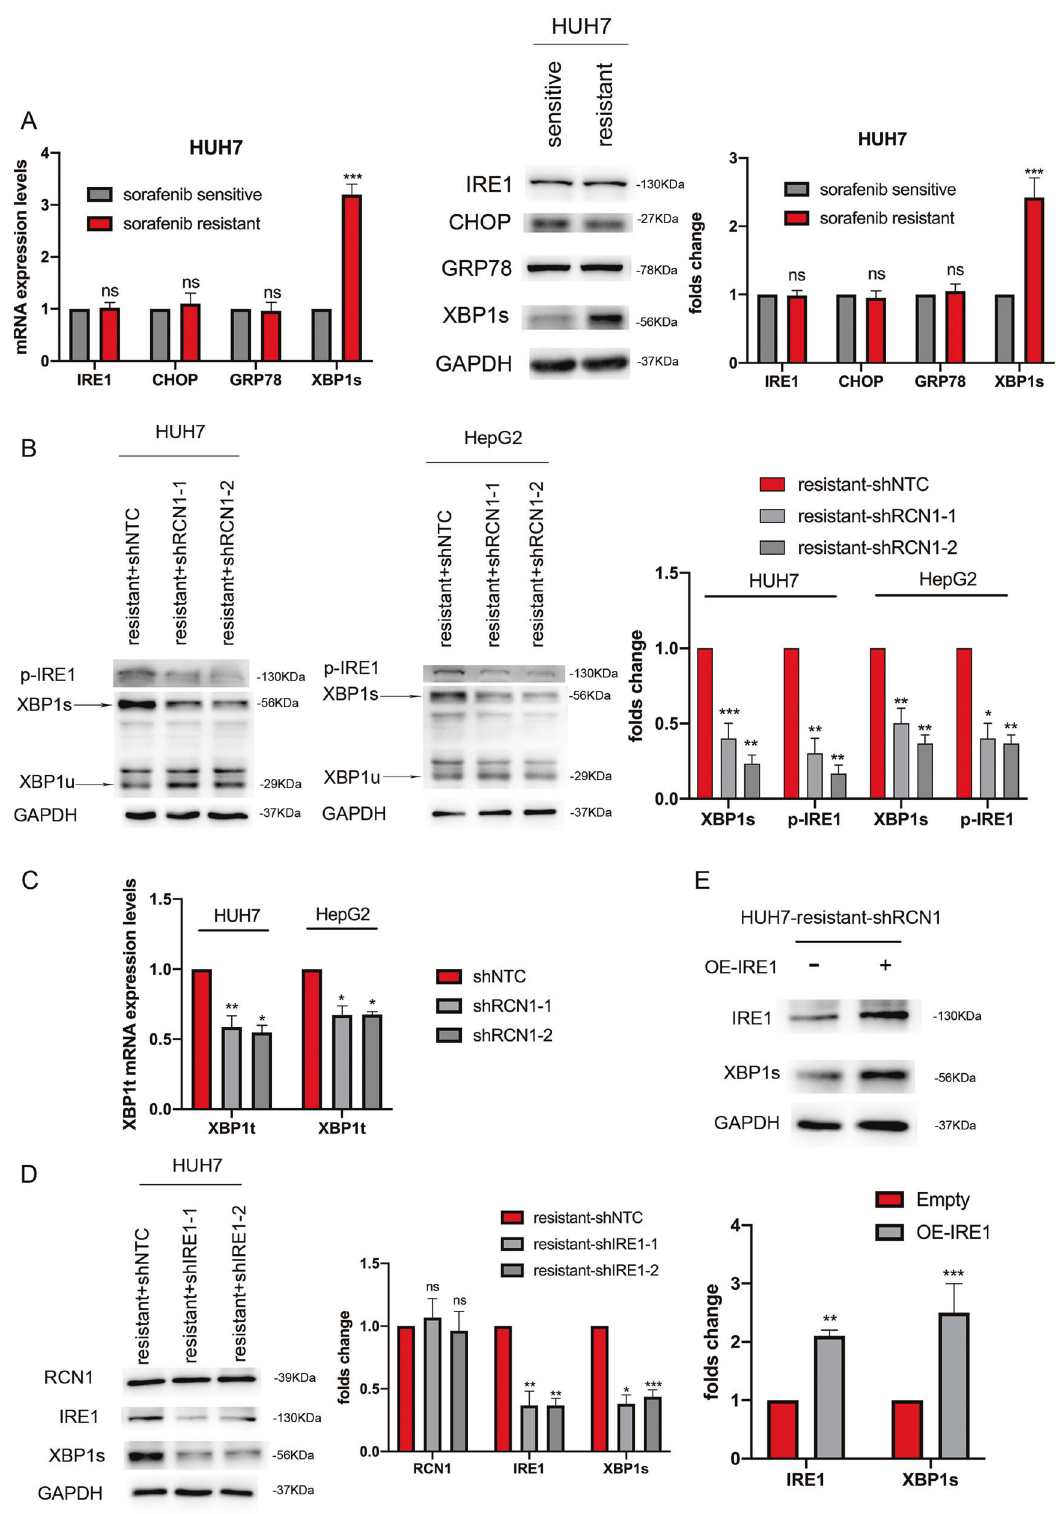
Fig. 3 RCN1 contributes to selective activation of the unfolded protein response. A qRT-PCR and western blot analysis showing the mRNA and protein levels of IRE1, CHOP, GRP78, and XBP1s in sorafenib-resistant and sorafenib-sensitive Huh7 cells. B Western blot analysis showing protein levels of XBP1 and p-IRE1 α in sorafenib-resistant Huh7 cells with or without RCN1 silencing. C Total mRNA levels of XBP1 in RCN1- knockdown drug-resistant cells. D , E Western blot analysis of RCN1, IRE1 α , and XBP1 expression in sorafenib-resistant Huh7 cells with downregulated or overexpressed IRE1. Data are presented as the means ± SEM of three independent experiments; data for western blot have undergone quantitative analysis. ns not signi fi cantly different. * P < 0.05; ** P < 0.01; *** P < 0.001, t-test.